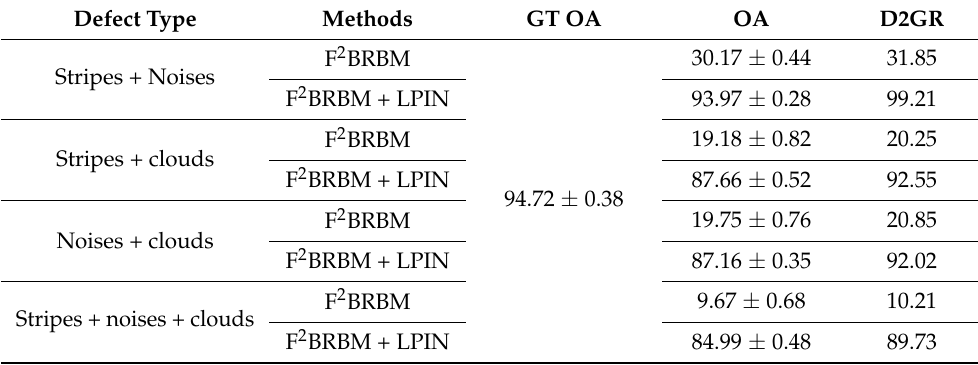
Table 13. OA (%) and D2GR (%) of F2BRBM and F2BRBM+LPIN on NWPU-RSISC45 Dataset with Combined Defects.